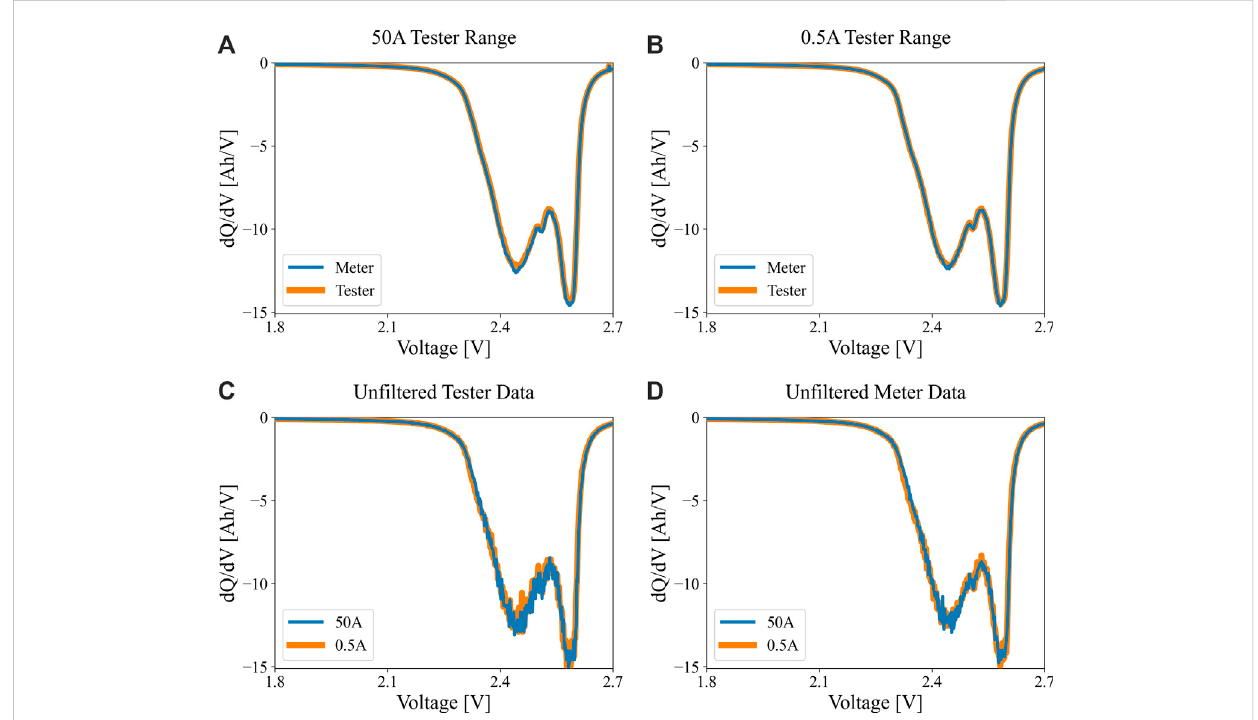
FIGURE 5 Differentialorincrementalcapacitysignatures(dQ/dV)foranLMO/LTOcell,comparingC/20dataobtainedthrough (A) 50 AMaccorrange(orange) versus the Keysight multimeter (blue), and (B) 0.5 A Maccor range (orange) versus the Keysight multimeter (blue). Panels (C) and (D) show the un fi ltered data for 50 A (blue) and 0.5 A (ornage) ranges for the tester and meter, respectively.